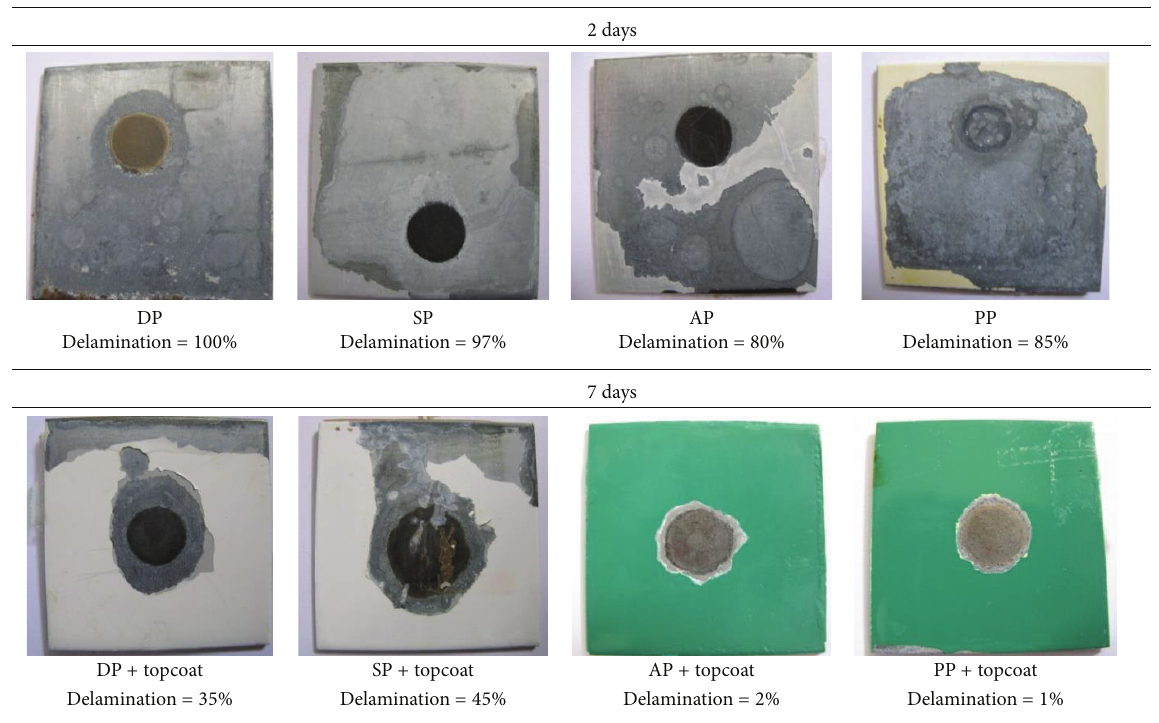
Figure 8: Delamination of primers and primer/topcoat systems applied on hot-dip galvanized steel after exposure in 3% NaOH